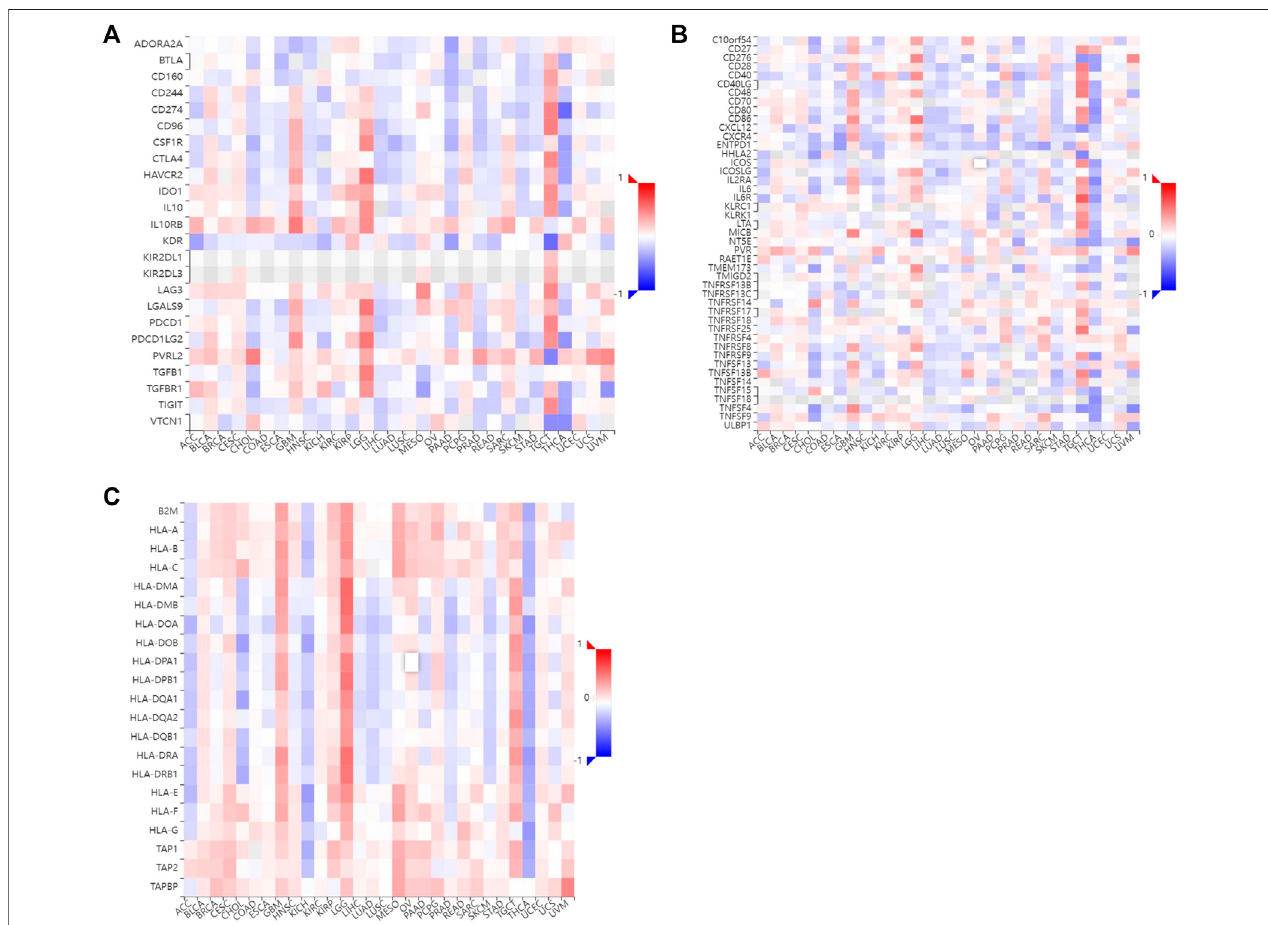
FIGURE 7 | The relationship between H2BC12 and immune regulatory factor. The level of H2BC12 mRNA was positively correlated with immune inhibitors (A) , immune stimulators (B), and MHC molecules (C) . Red indicated a signi fi cant positive correlation, and blue indicated a signi fi cant negative correlation.